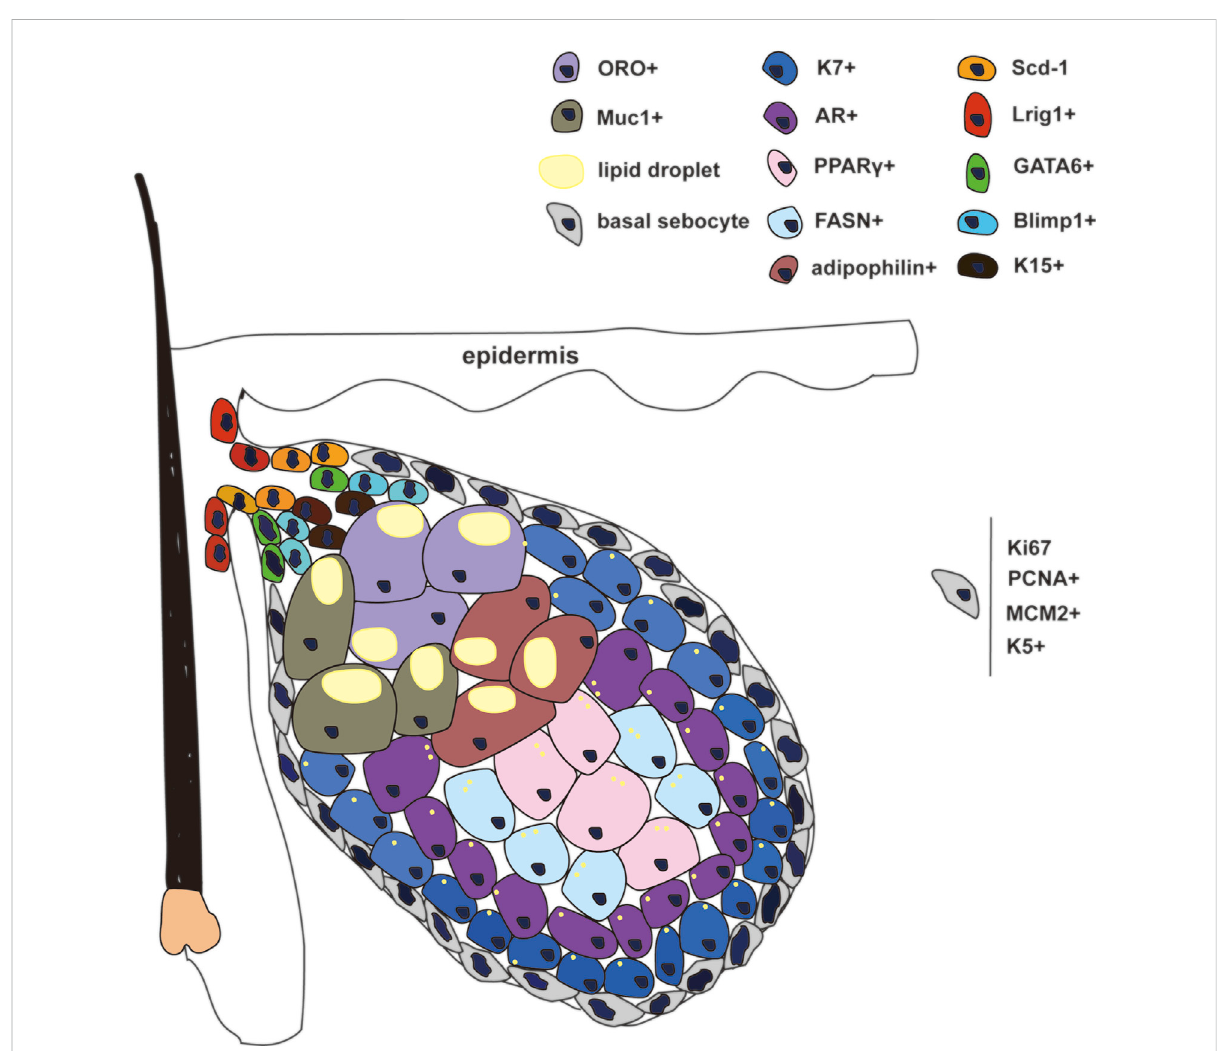
FIGURE 1 DifferentstagesofcellpoolsandcorrespondingbiomarkersinSG.Lrig1+,Scd-1,K15+,andGATA6+cellsrepresenttheprogenitorcellsaround the gland duct. Basal sebocytes can proliferate and differentiate. K7+ and AR+ cells represent the early differentiatedsebocytes. PPAR γ + and FASN+ represent the differentiated sebocytes in the middle stage. ORO+ and Muc1+, and Adipophilin+ cells represent the terminally differentiated